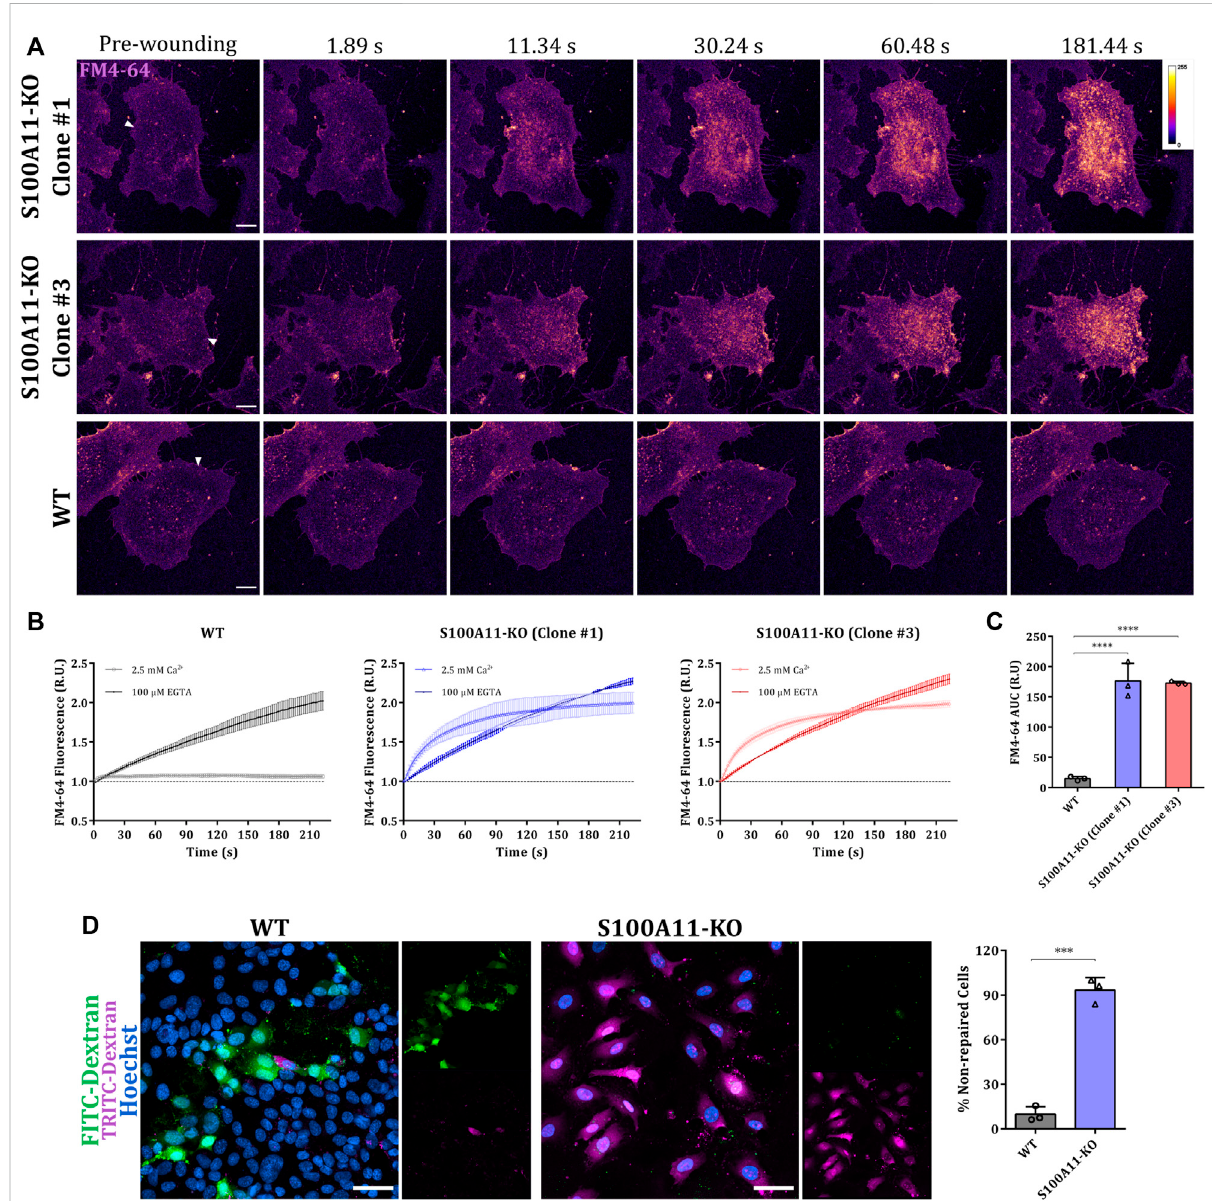
FIGURE 1 Plasma membrane repair is defective in S100A11-KO EA.hy926 cells. (A) Representative images of FM4-64 in fl ux following membrane damage in S100A11-KO, clone #1 and #3, or WT EA.hy926 cells (see Supplementary videos S1, S3). Cells kept in Tyrode ’ s buffer supplemented with 2.5 mM Ca 2+ and 5 μ g/ml FM4-64 were injured by laser ablation at 820 nm (near infrared) directed at the plasma membrane on the lateral edge (white triangles represent the wound sites). Wounding occurred at t = 0; pre-wounding and post-wounding time points are shown. Calibration bar of fl uorescence intensity is provided in the upper right panel. Scale bars = 10 µm. (B) Time course of whole-cell FM4-64 fl uorescence normalized to fl uorescence before injury in WT (left) or S100A11-KO cells (clone #1: middle and clone #3: right) laser-ablated in the presence of extracellular Ca 2+ orEGTA. (C) AUCvaluesofFM4-64 fl uorescenceinWTorS100A11-KOcellsdamagedinthepresenceofextracellularCa 2+ .S100A11-KO, n =27cells per clone; WT, n = 18 cells. Results were pooled from three independent experiments. Statistical analysis was performed with ordinary one-way ANOVA. (D) Exemplary fi elds of mechanically wounded WT or S100A11-KO cells stained with FITC-Dextran, TRITC-Dextran and Hoechst. The protocol (see Materials and Methods) permits the distinction between wounded and repaired cells (that had taken up only FITC-Dextran) and wounded but non-repaired cells (that had taken up FITC-Dextran and TRITC-Dextran). Hoechst was included as a marker for all cells. Scale bars = 50 μ m. Quanti fi cation of non-repaired WT or S100A11-KO cells, represented as a percentage of total wounded cells (right). Results were pooled from three independent experiments ( n = 75 fi elds). Statistical analysis was carried with two-tailed Student ’ s t test. Data are mean ±